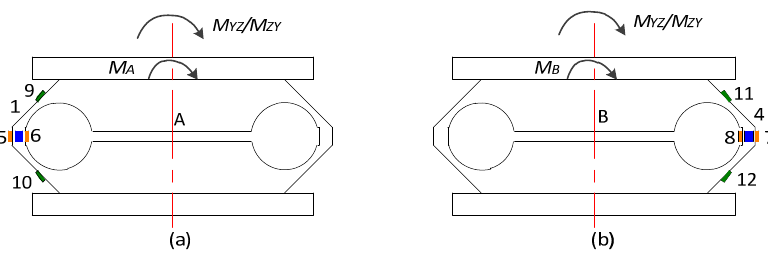
Figure A7. ( a ) Elastic Beam A under X axial moment; ( b ) Elastic Beam B under X axial moment.